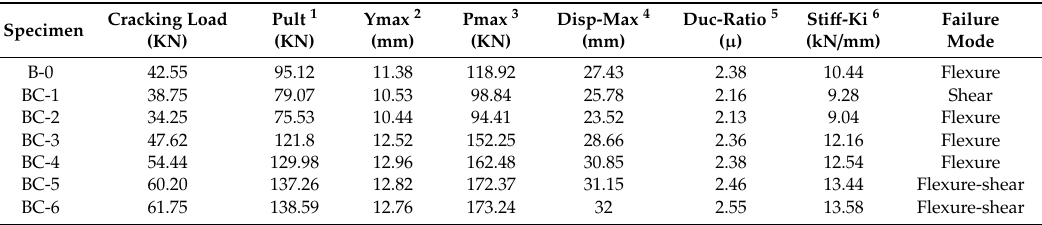
Table 4. Key results of tested beams.